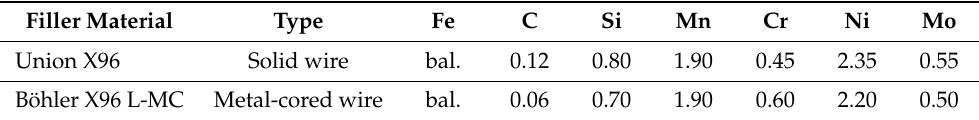
Table 3. Chemical composition of the filler materials: Union X96 and Böhler X96 L-MC (wt.%).